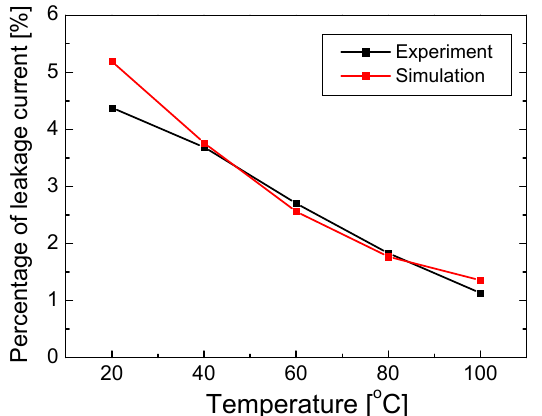
Figure 5. Simulated and experimented P leak values as a function of temperature ranging from 20 to 100 °C.